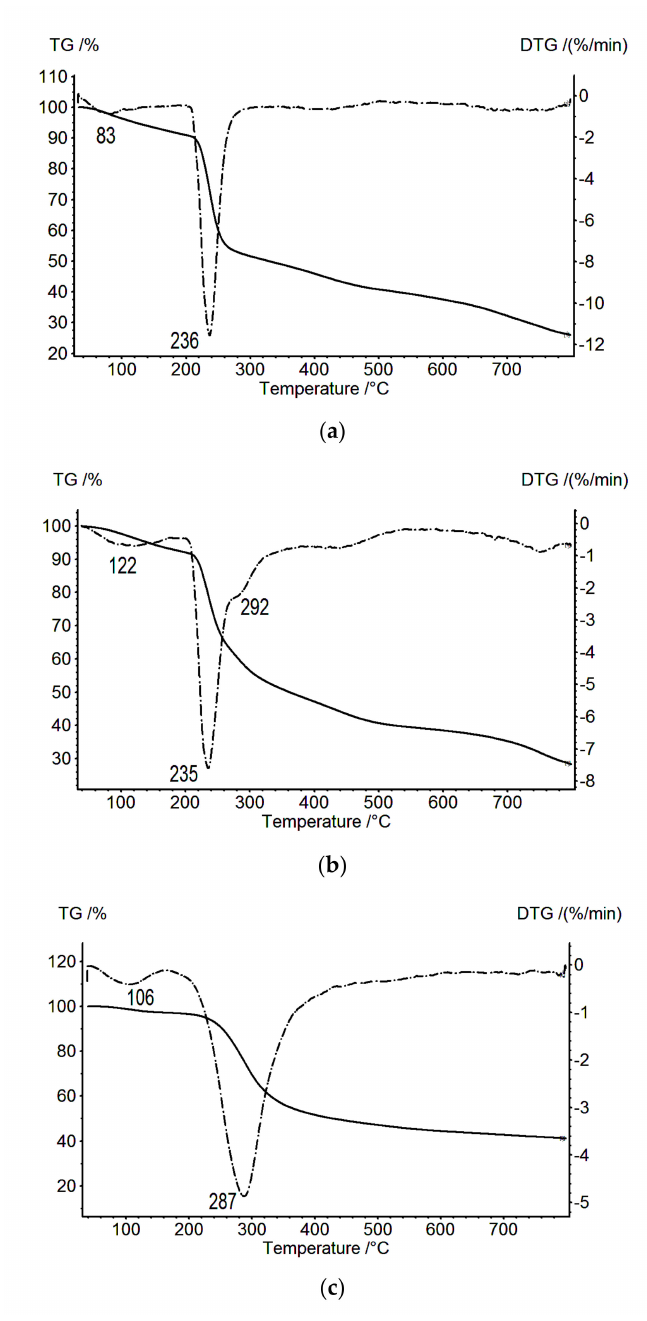
Figure 2. Thermogravimetric (TG; solid lines) and differential thermogravimetric (DTG; dotted lines) curves: ( a ) ALG, ( b ) CS s –PEC ALG –ALG, and ( c ) CS b –PEC ALG